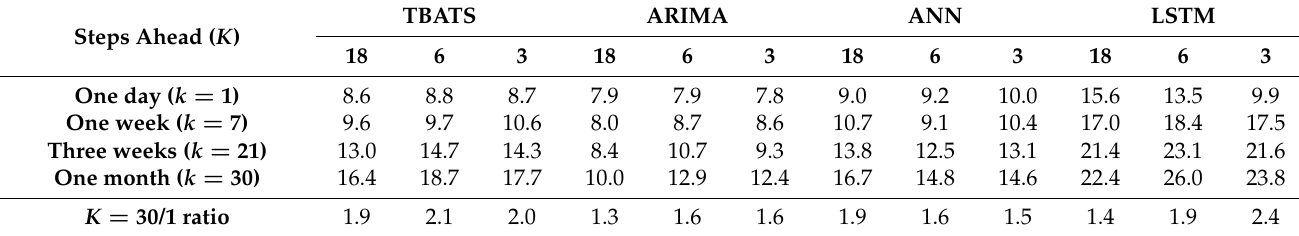
Table 8. Accuracy of rolling forecasting with different historical lengths (3, 6, and 18 months) at the city scale. Steps Ahead ( K